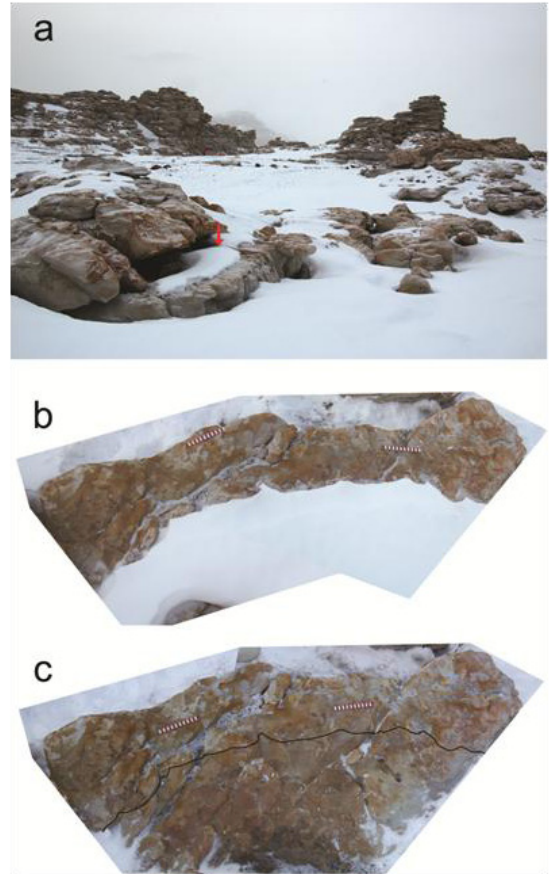
Figure 5. Evidence that persistent thick snow covers are detrimental. ( a ) Partially-covered sandstone surface in the lee of a boulder (red arrow) on Battleship Promontory after winds cleared the snow off the area around the edge. ( b ) View of the exposed area from above, showing that it is heavily colonized. ( c ) View after the snow was deliberately removed, showing that the covered area (below the added black line) is largely devoid of biological activity. (Scale 20